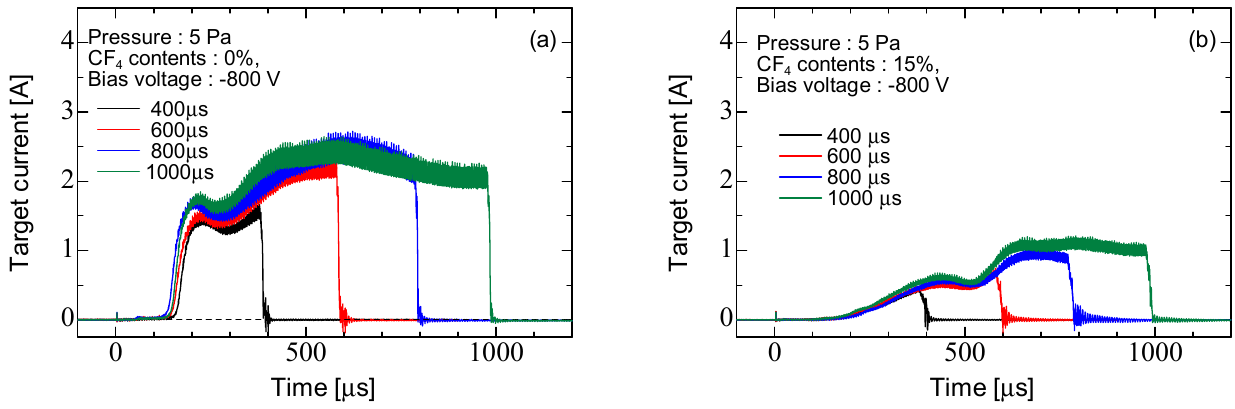
Figure 7. Waveform of target current at each burst width ( a ) Ar discharge and ( b ) Ar/CF 4 discharge.